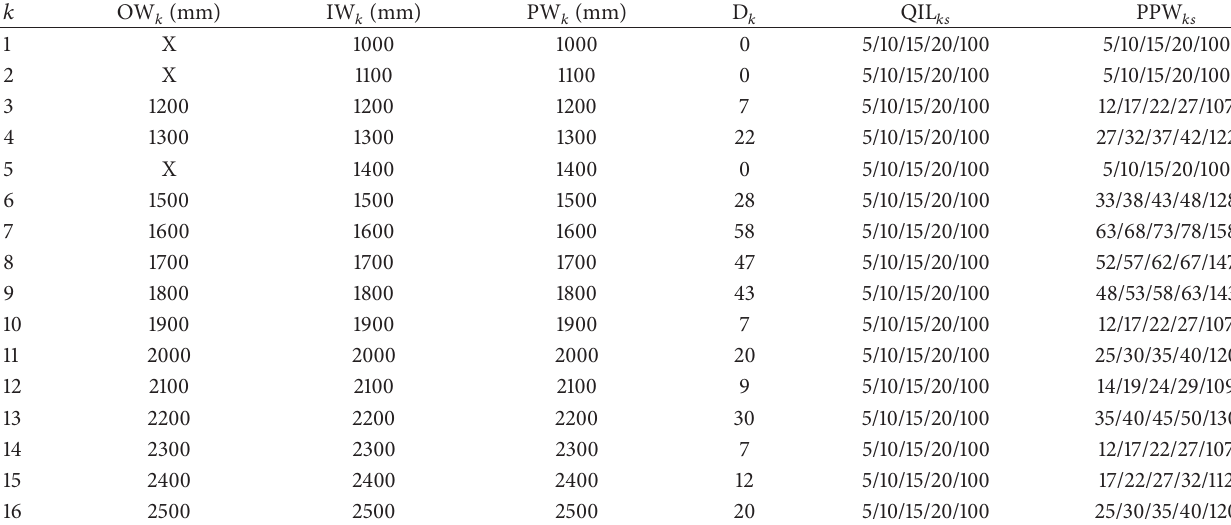
Table 1: Product order information and adjusted data for PW 𝑘 , QIL 𝑘𝑠 , and PPW 𝑘𝑠 .